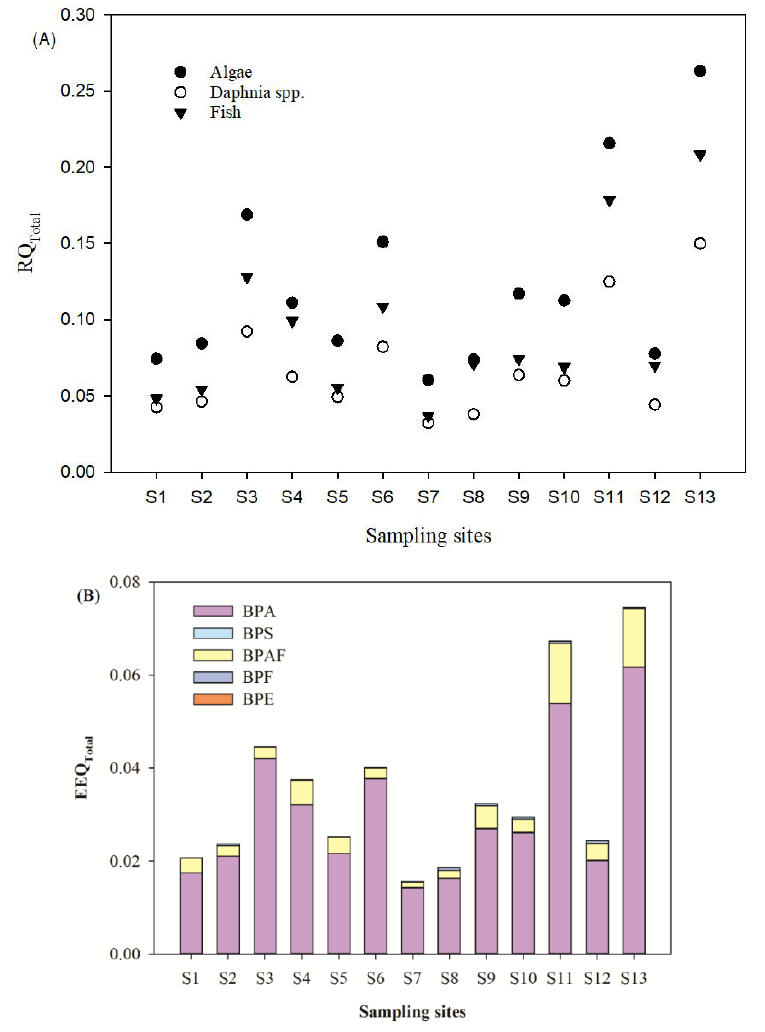
Figure 6. The RQ Total ( A ) and EEQ Total ( B ) of BPs for aquatic organisms in the surface water.